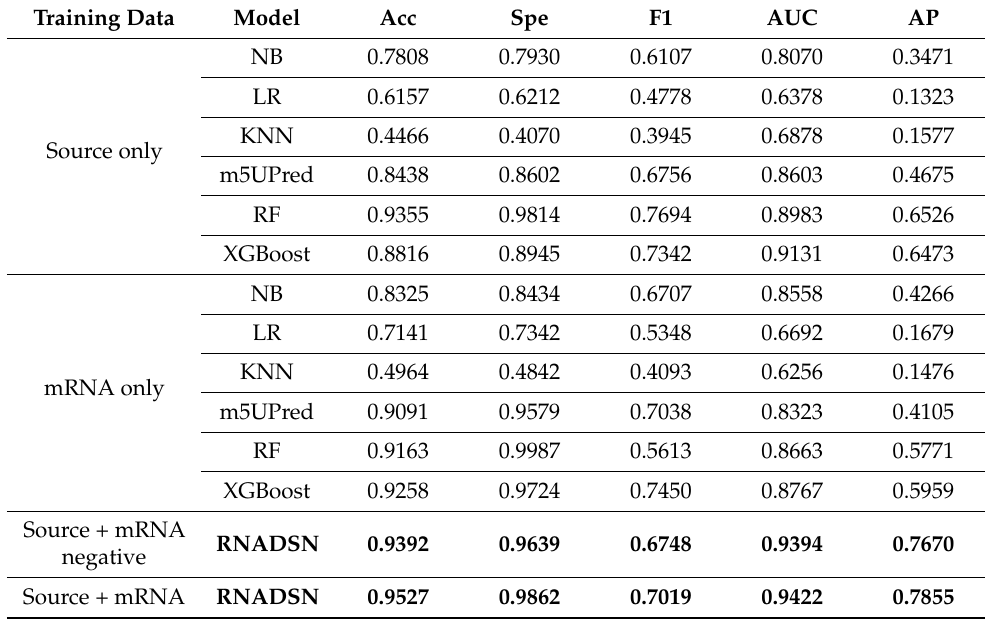
Table 2. Model performance using different training